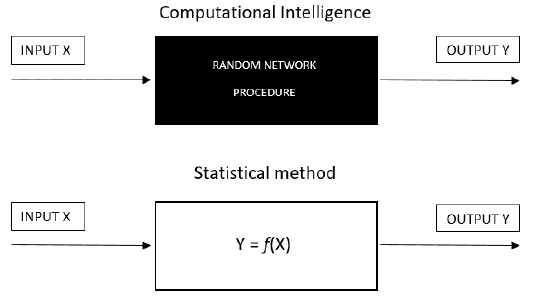
Figure 1. The computational intelligent (CI) method and statistical